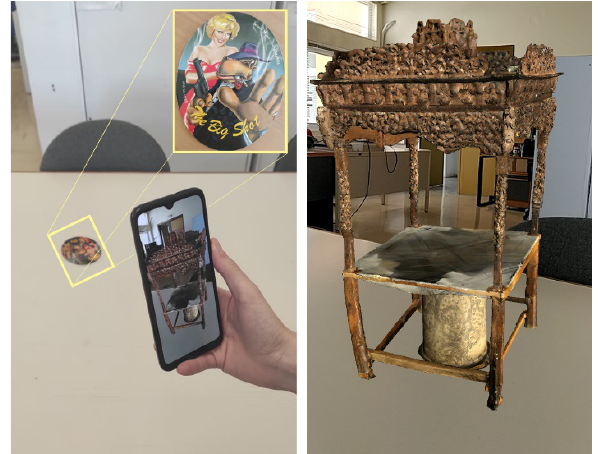
Figure 6 . Different views during the AR session of the application. Left: Photograph showing the pattern image and the screen display of the 3D overlay; Right: The 3D model of Ciborium as it is superimposed on top of the object.